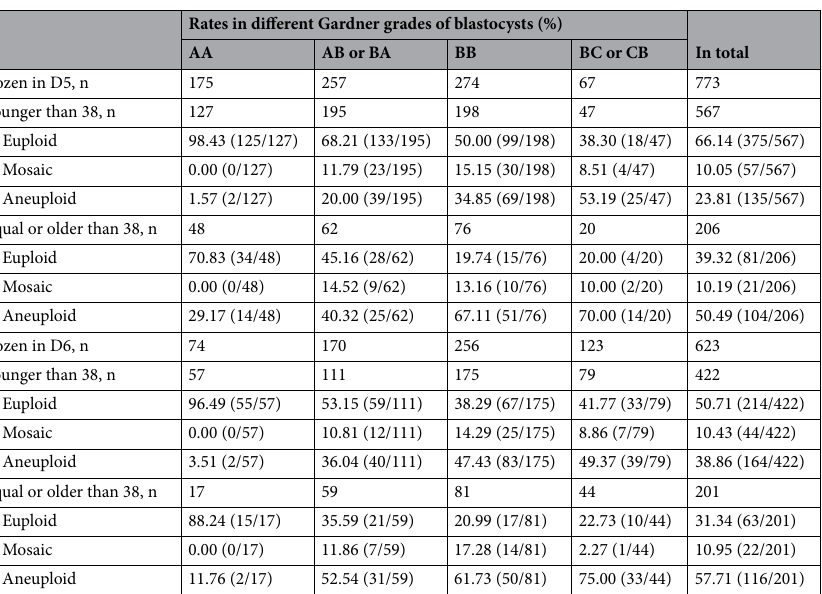
Table 2. Relationship between Gardner grade and euploidy of blastocysts.